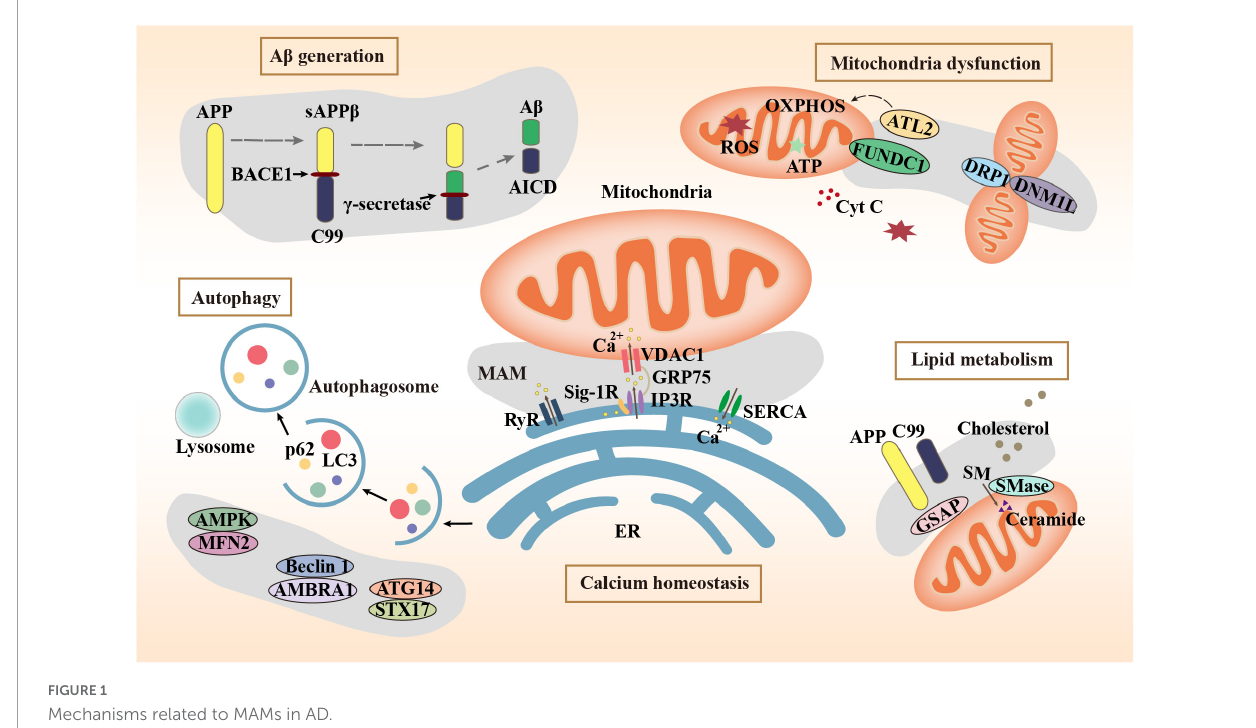
FIGURE1 Mechanisms related to MAMs in